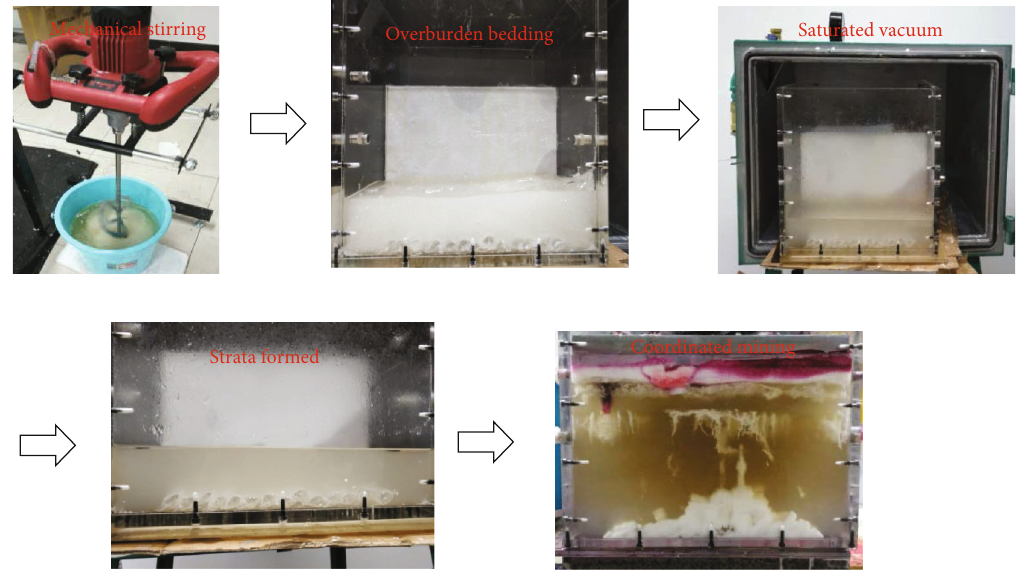
Figure 5: Preparation process of the transparent strata.